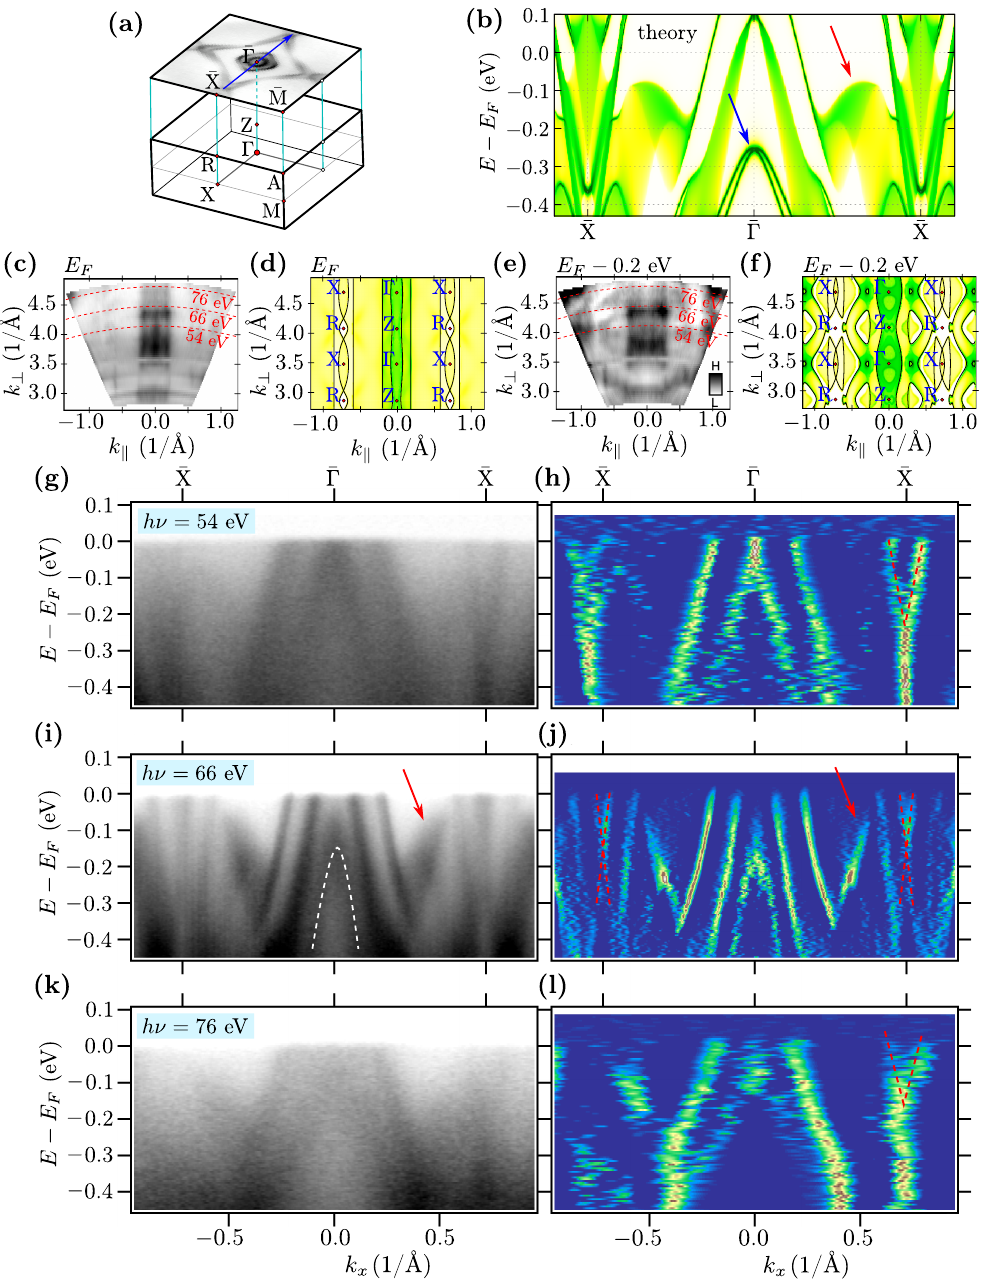
Figure 9. Cartoon representation of the bulk first Brillouin zone projection into the surface Brillouin zone ( a ). Theoretical surface spectral function along the ¯X–¯ Γ –¯X direction ( b ). Panels from ( c – f ) present intensity plots for constant energy planes at the Fermi level E F and energy E F − 0.2 eV (as labeled). The ARPES spectra ( c , e ) were collected in the photon energy range from 20 to 80 eV. The calculated band structure (solid black lines) along with the spectral function (background color scale) is shown in ( d , f ). Here, the intensity maps is a function of k ⊥ = k z and k (cid:107) = k x (perpendicular and parallel to the surface component of the wave vector). Panels ( g – l ) present experimentally obtained spectra and their 2D curvature (left and right panels, respectively) for different photon energies (as labeled). The red arrows in ( b , i , j ) indicate the position of additional structure in the spectra that can be explained by the projection of the bulk band on the surface Brillouin zone. The blue arrow in ( b ) and white dashed parabola in ( i ) indicate the surface state. The red dashed lines in ( h , j , l ) refer to the position of the band crossing of the band forming the nodal line. The measurements were made at the temperature of 12